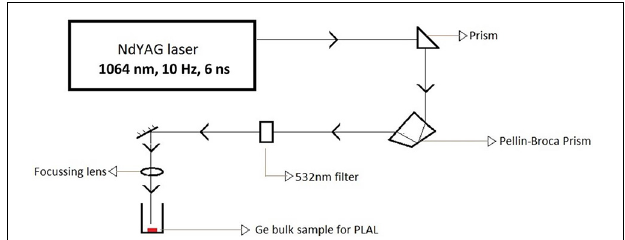
FIGURE 1 | Schematic of the experimental setup of pulsed laser ablation in